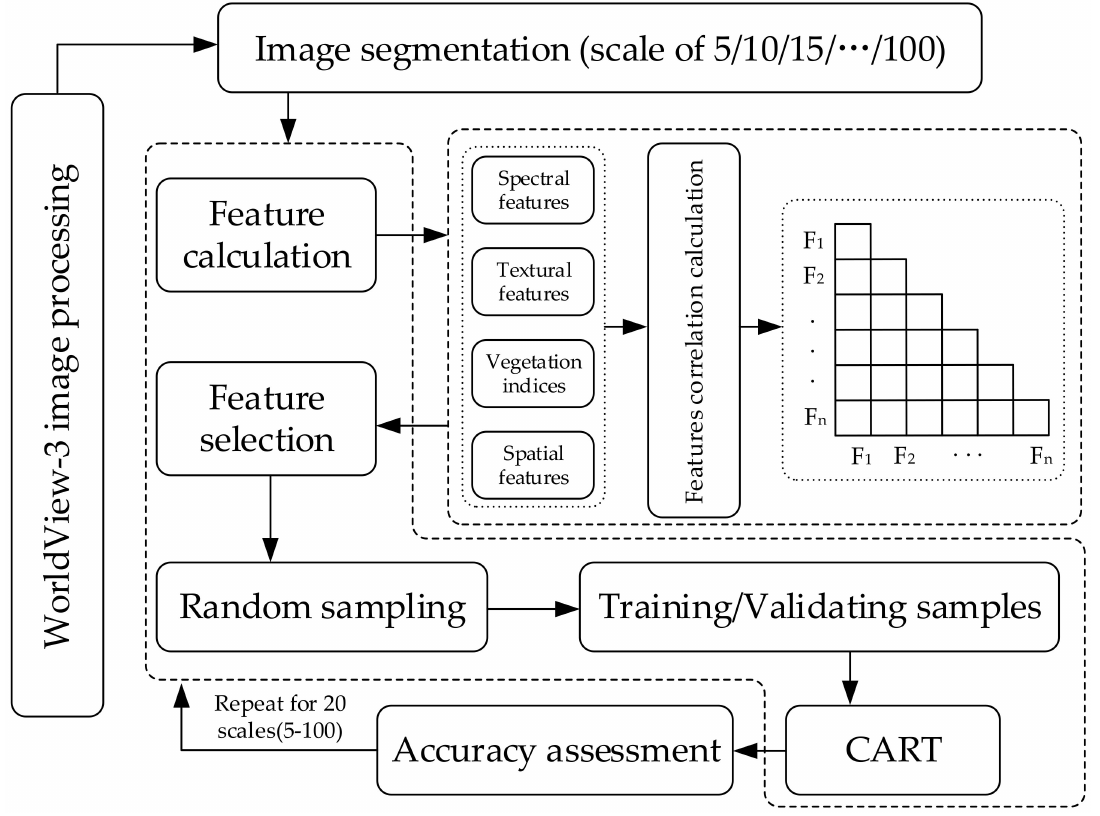
Figure 2. Flowchart of the study